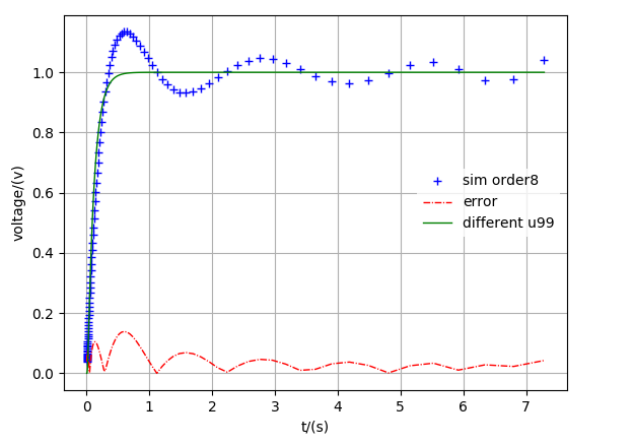
Figure 9. Simulation eight-order.